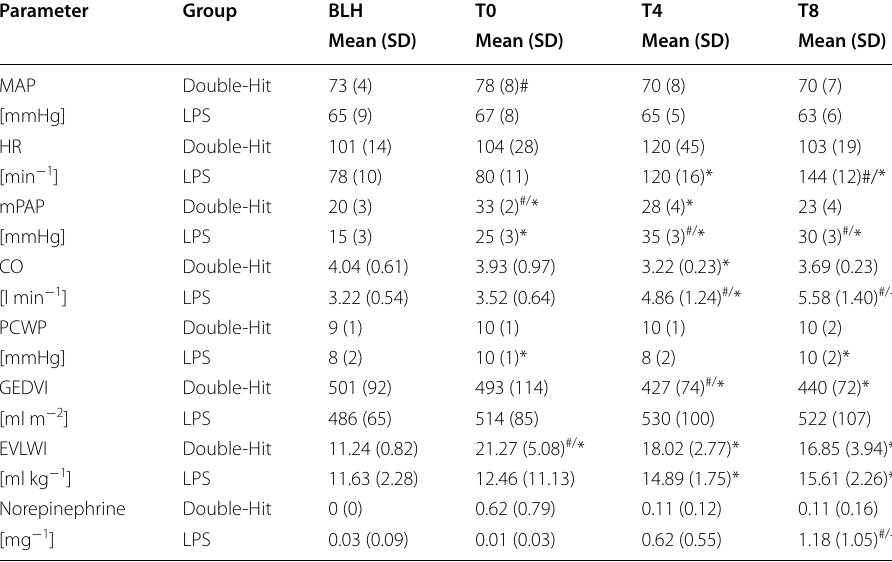
* Indicates p < 0.05 vs. baseline value. # indicates p < 0.05 in intergroup comparison MAP: mean arterial pressure; HR: heart rate; mPAP: mean arterial pulmonary pressure; CO: cardiac output; PCWP: pulmonary capillary wedge pressure; GEDVI: global end‑diastolic volume index; EVLWI: end‑diastolic lung water